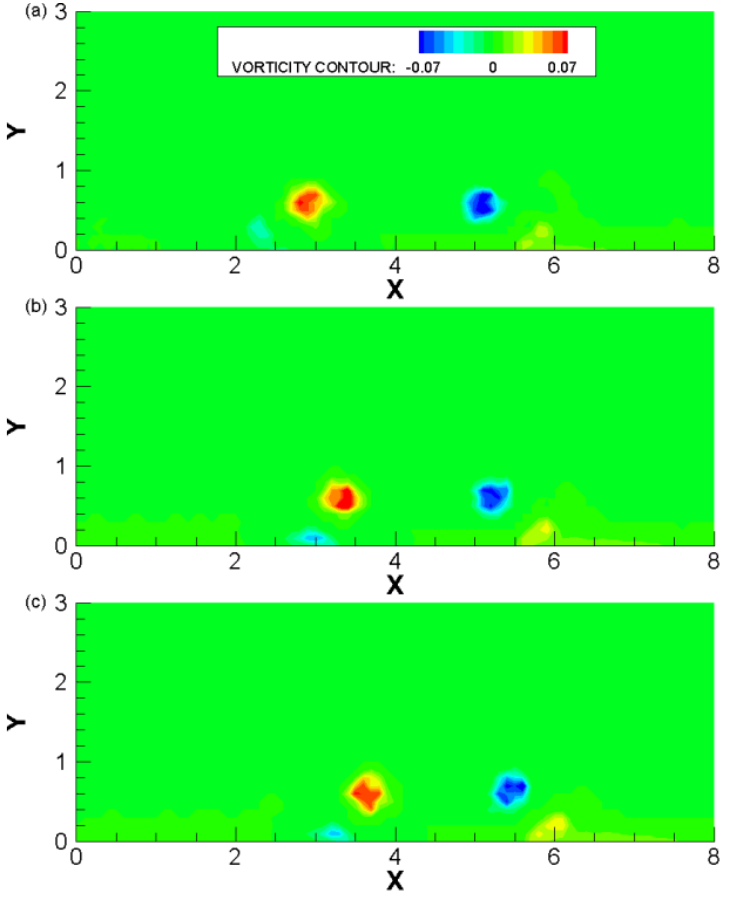
Figure 9. Instantaneous vorticity field behaviors under crosswind velocities at the initial moment of interaction between the primary vortical structures and the ground plane (Re = 7650 and Ri = 0.0): ( a ) t = 15.95 and U ∞ = 0.0; ( b ) t = 14.45 and U ∞ = 0.02; and ( c ) t = 13.95 and U ∞ = 0.04. The mixed convection heat transfer is now considered in the presence of crosswind velocities of magnitude U ∞ = 0.02 and 0.04 to allow investigations of these combined effects. For this purpose, as performed in Section 4.2, as previously presented, the Richardson number also assumes the values of Ri = 1.018 and